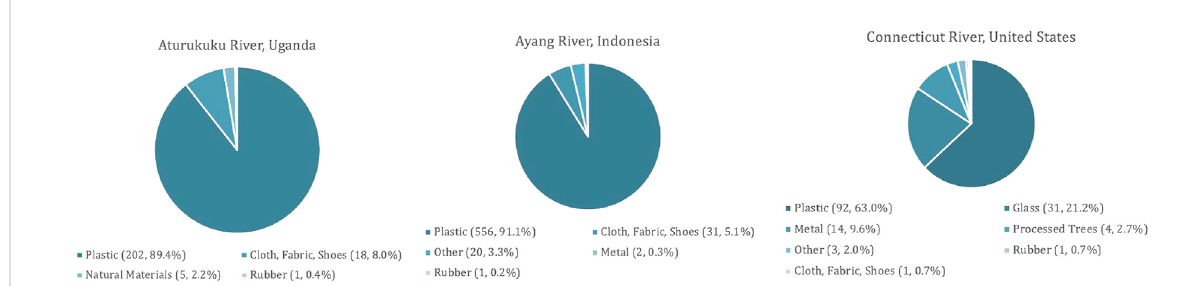
FIGURE 2 ProportionaldistributionofmaterialfoundintheAturukukuRiver,Uganda,theAyungRiver,Indonesia,andtheConnecticutRiver,UnitedStates with material type (count, percentage).